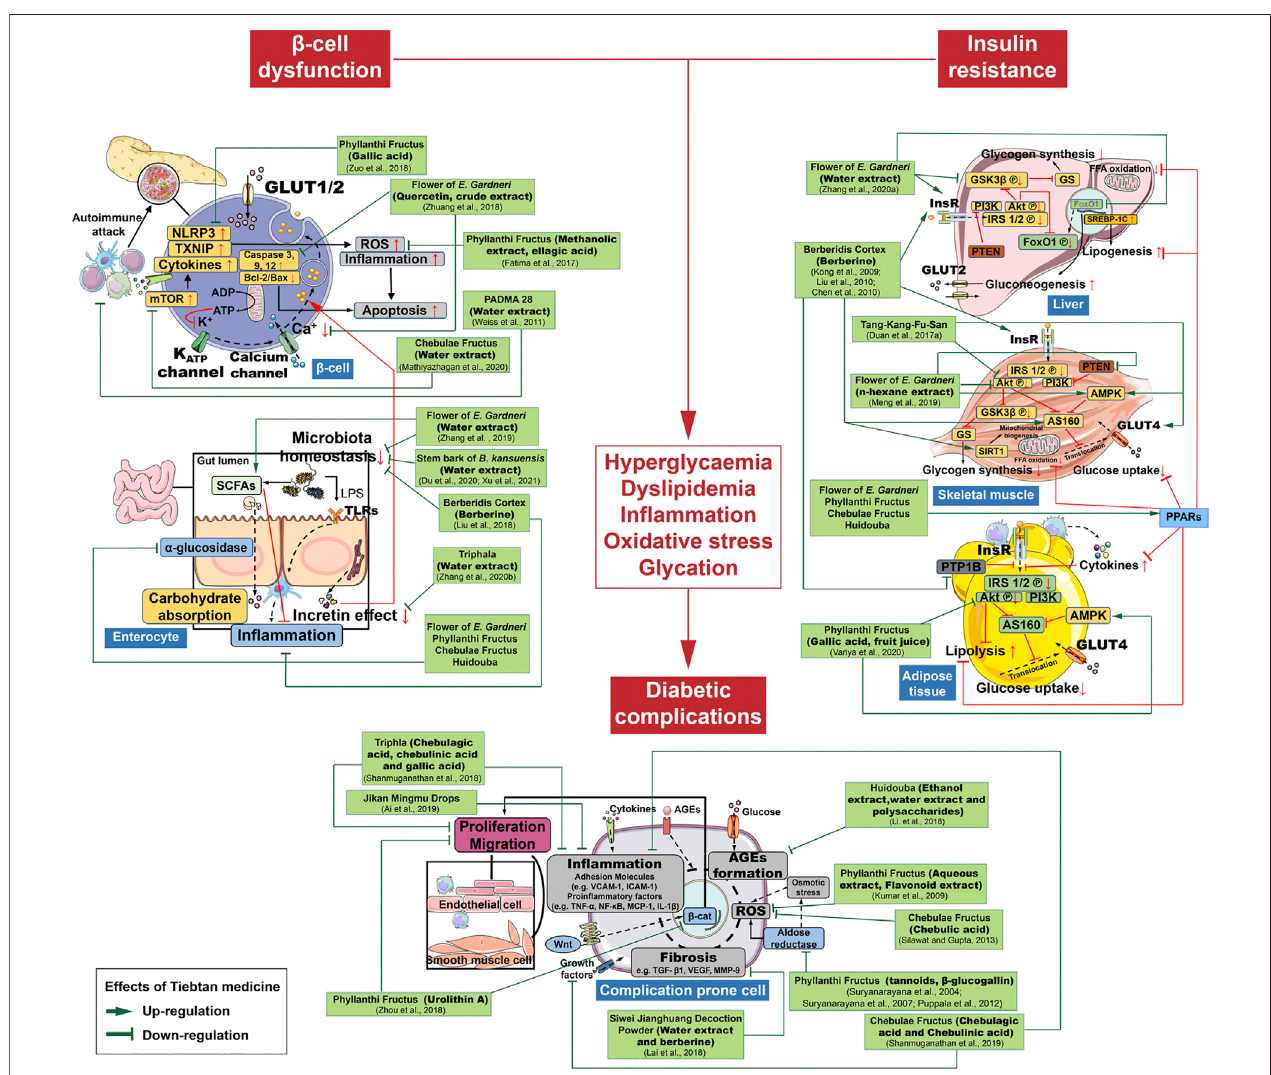
FIGURE 3 | Schematic diagram showing the possible molecular targets of speci fi c bioactive extracts and components from Tibetan medicines.